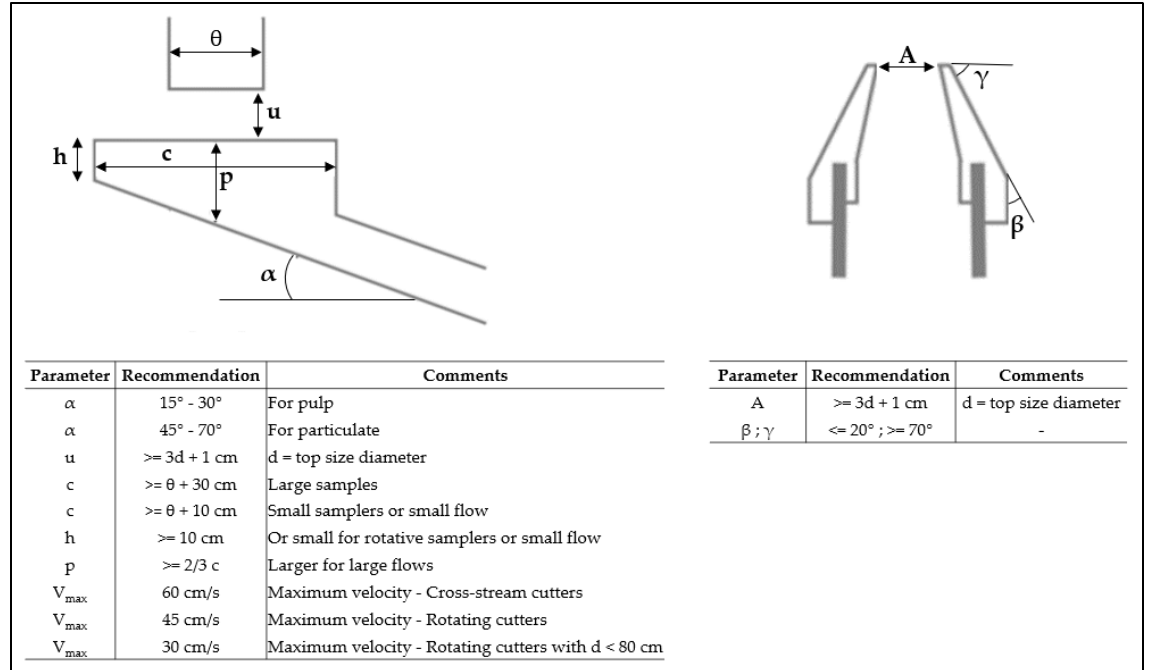
Figure 2. Parameters for design samplers, adapted from [4].